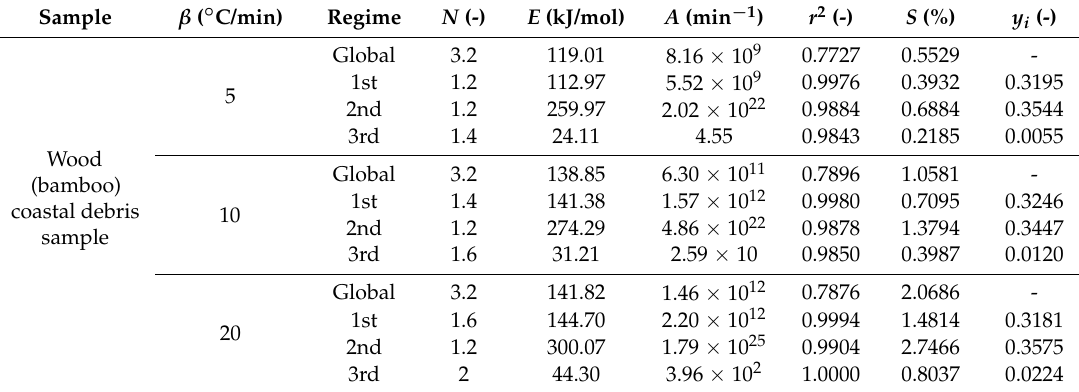
Table 5. Kinetic parameters of the wood coastal debris sample in the pyrolysis process at different heating